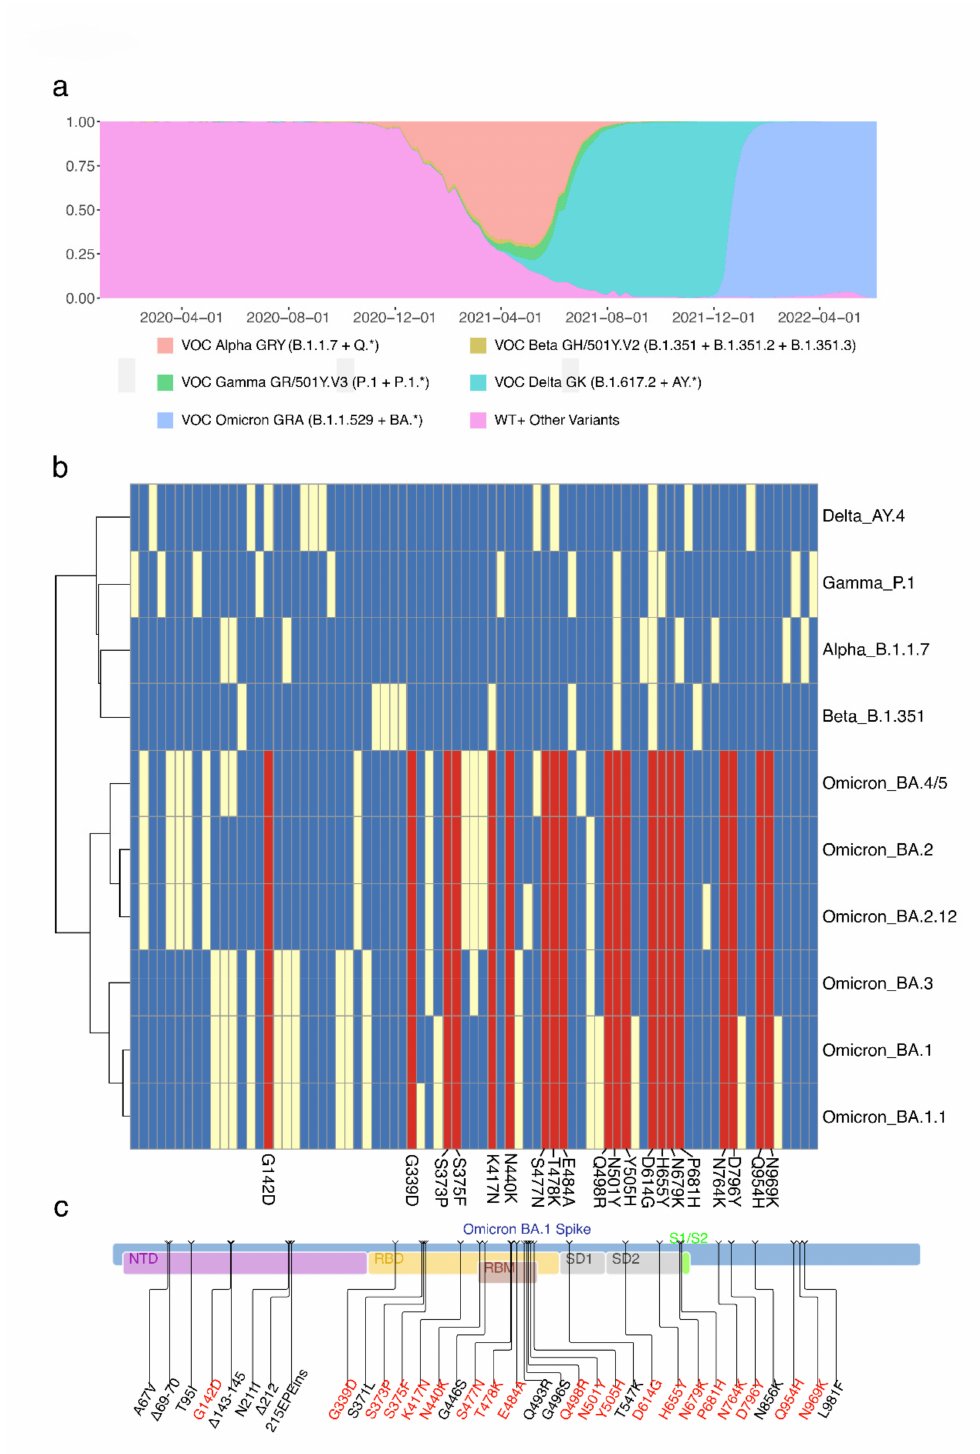
Figure 1. Twenty core mutations in the spike protein of Omicron variants. ( a ) The proportion of SARS-CoV-2 variants of concern (VOCs). ( b ) Mutations in the spike protein of VOCs. Red boxes are the spike amino acid mutations shared in Omicron sub-variants; yellow boxes are other spike amino acid mutations; blue boxes are wild types. ( c ) The positions of 20 core mutations in the spike of Omicron BA.1. Mutations with red color are the shared mutations in Omicron